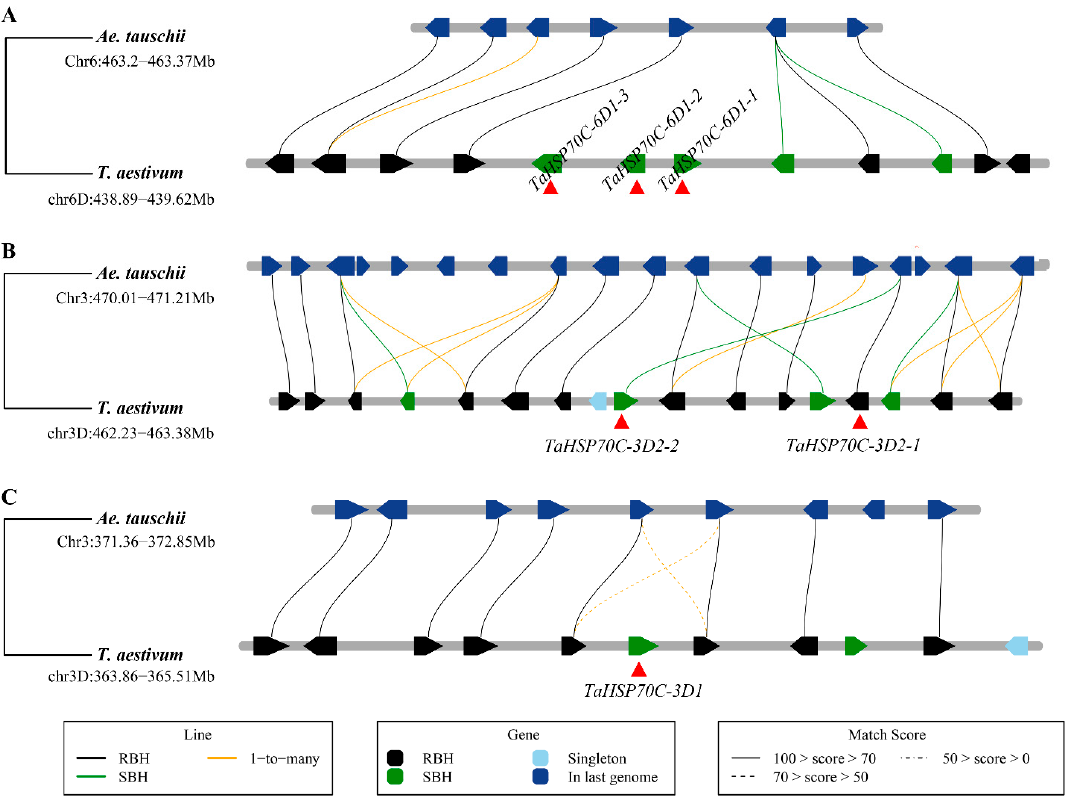
Figure 3. Synteny analysis of the duplicated TaHSP70s in the subfamily cytosol. Genes were represented by pentagons, types of homeologous relationship are indicated by different colors. RBH, reciprocal best hits. SBH, single-side best hits. ( A – C ) Distribution of genes next to the duplicated TaHSP70s in the collinear blocks between Ae. tauschii and hexaploid wheat.